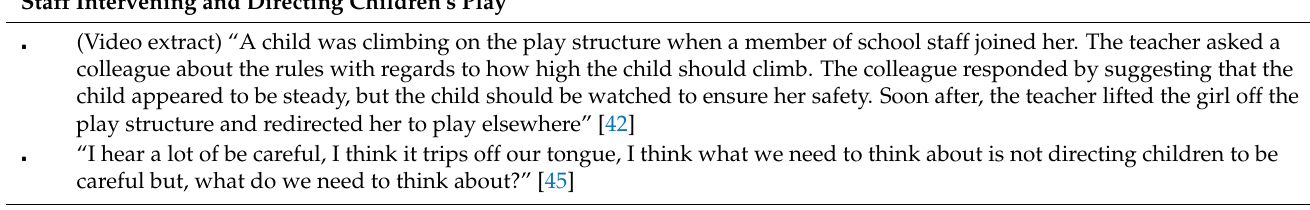
Table 5. Synthesised finding 3: Stepping in and stepping